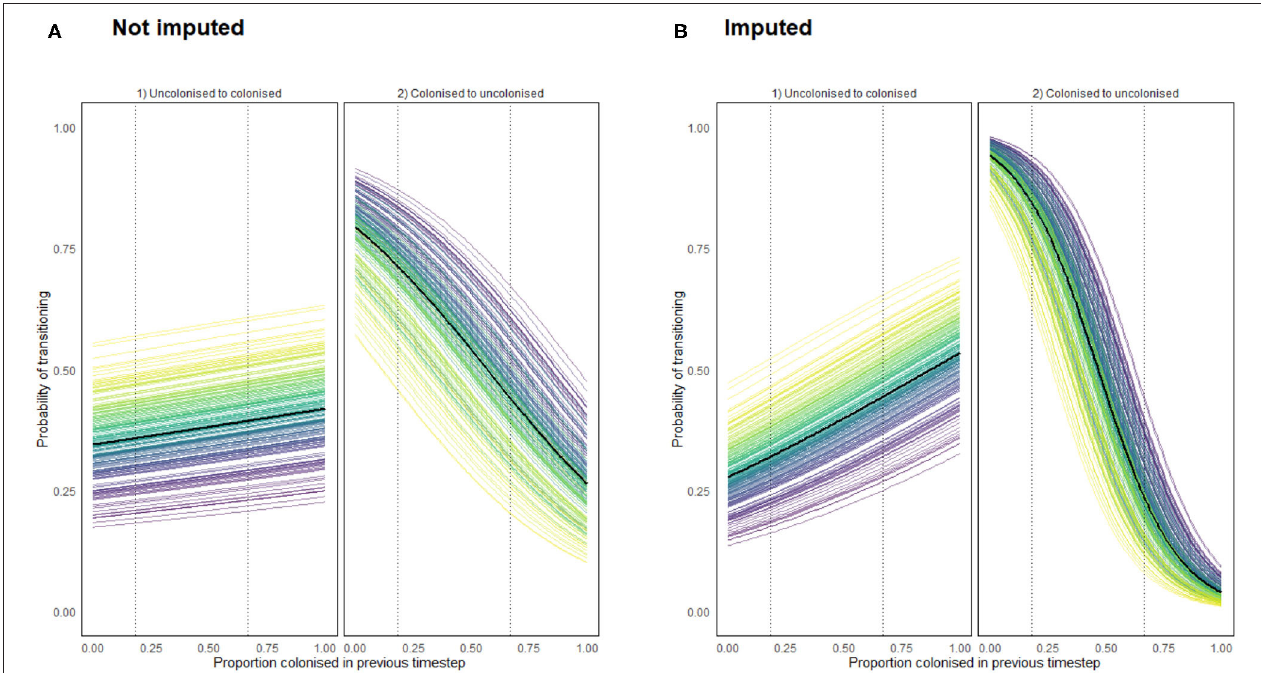
FIGURE 11 | Transition probabilities from a state of uncolonization (by Campylobacter ) to colonization, and from colonization to uncolonization using a density dependent model programmed using (A) recorded data (B) recorded and imputed data. Each colored line represents the transition probabilities for a single chicken, with a black line depicting the flock mean. Dotted lines show the region for which data was available for such a flock colonization